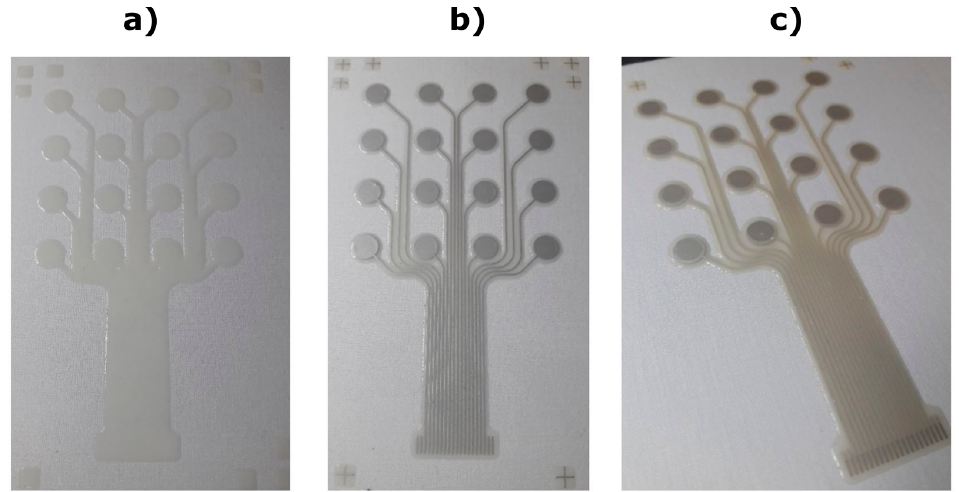
Figure 2. The printed electrode stages when printing on a polyester cotton woven textile. ( a ) Primer layer. ( b ) Conductive layer. ( c ) Encapsulation layer. The electrode pads remain exposed so that the subsequent skin-electrode interface material can be applied.